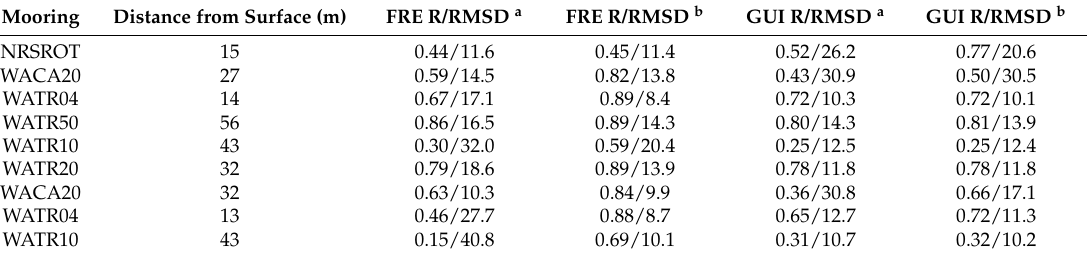
Table 4. Effects of SNR and velocity thresholds on radar data: a no threshold applied; b threshold applied. Mooring Distance from Surface